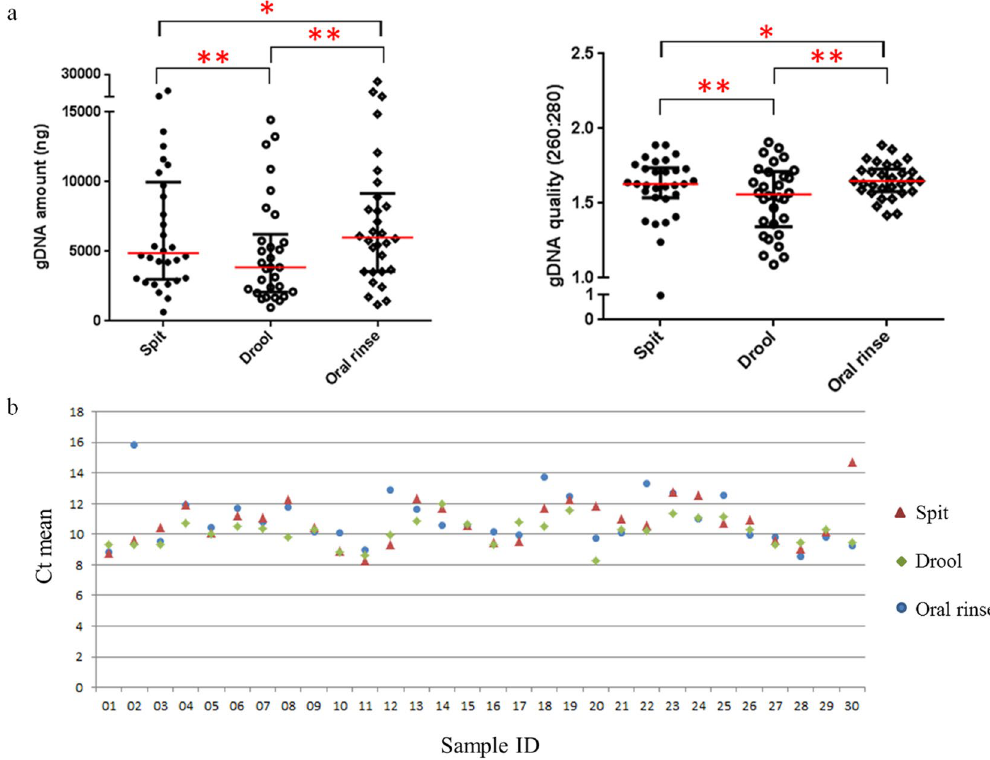
Figure 4. Extracted salivary gDNA from different saliva fractions. ( a ) Scatter plots for the quantity and quality of the extracted bacterial gDNA from each saliva fraction. Significant differences are denoted with * = p < 0.05, ** = p < 0.01, *** = p < 0.001, **** = p < 0.0001 respectively. ( b ) Bacterial 16S rRNA and human β -globin qPCR Ct means distribution trend for the extracted gDNA from spit, drool and oral rinse.